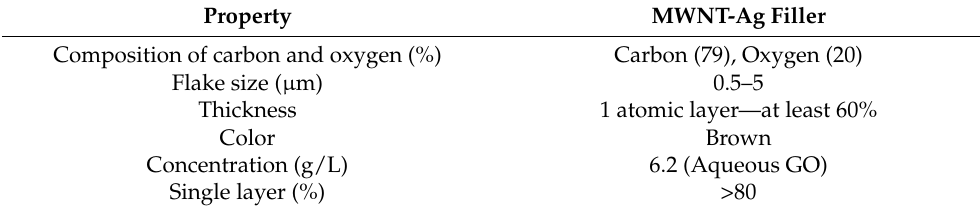
Table 2. Features of GO aqueous solution.